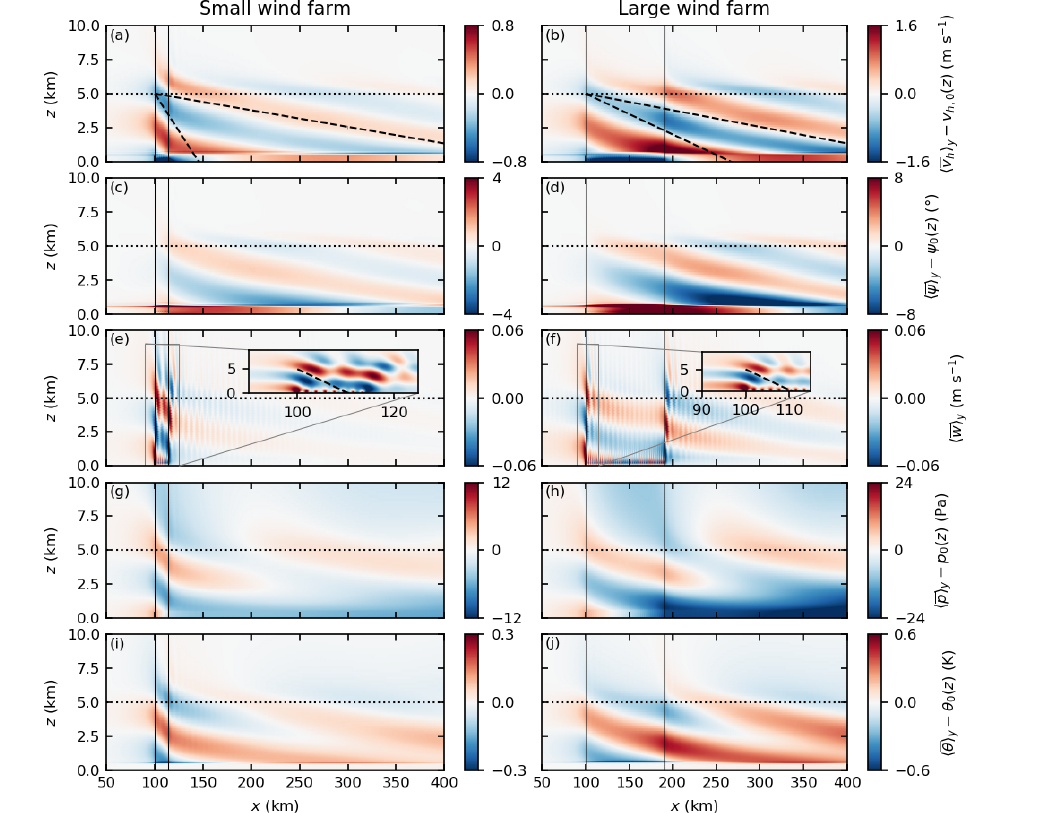
Figure 9. Vertical cross sections of the horizontal wind speed (a, b) , wind direction (c, d) , vertical wind speed (e, f) , perturbation pressure (g, h) and potential temperature (i, j) . The quantities are averaged in time and along y and the respective mean inflow is subtracted. Vertical lines mark the leading and trailing edge of the small (left) and large (right) wind farm. The bottom of the Rayleigh-damping layer is marked by a dotted line. Dashed lines indicate the inclination angles of the phase lines. The gravity waves at the leading edges are shown in detail in panels (e) and (f) . Note that the range of the color scale is only half as large for the small wind farm than for the large wind farm except for w . Table 1. Inclination angle of phase lines α and corresponding wavelengths for the different wave types present in Fig. 9. Wave